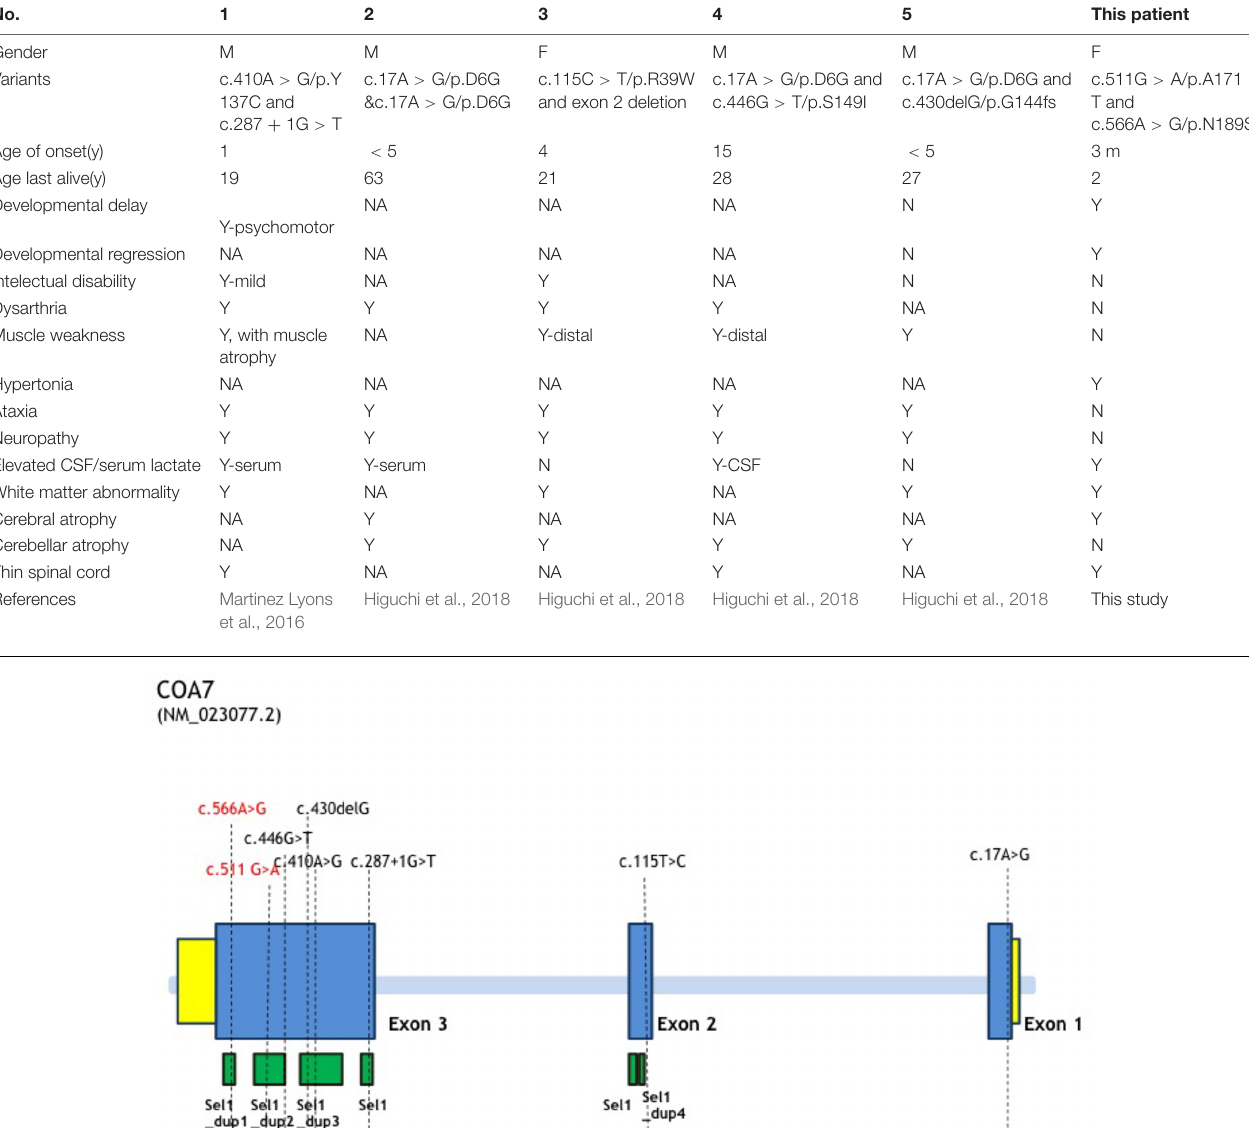
TABLE 3 | The clinical phenotypes of patients with biallelic mutations in COA7. No.